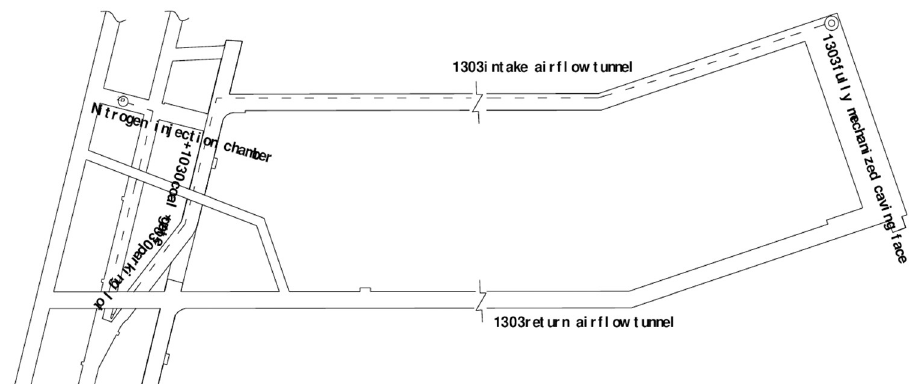
Fig 6. 1303 fully mechanized top-coal caving face goaf nitrogen injection circuit.